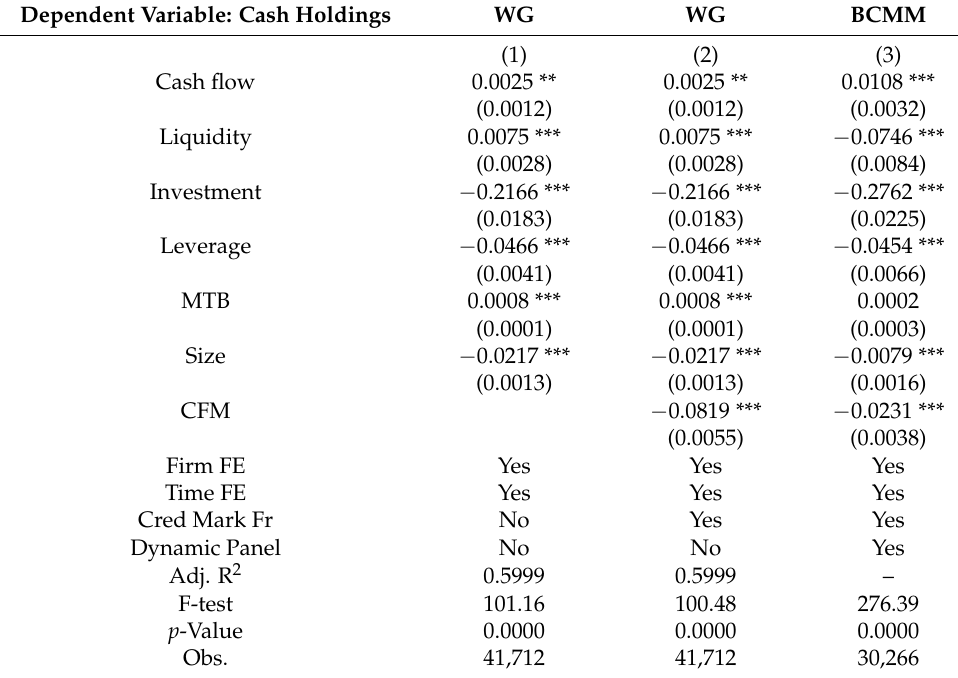
Table 7. Credit Market Freedom and Corporate Cash